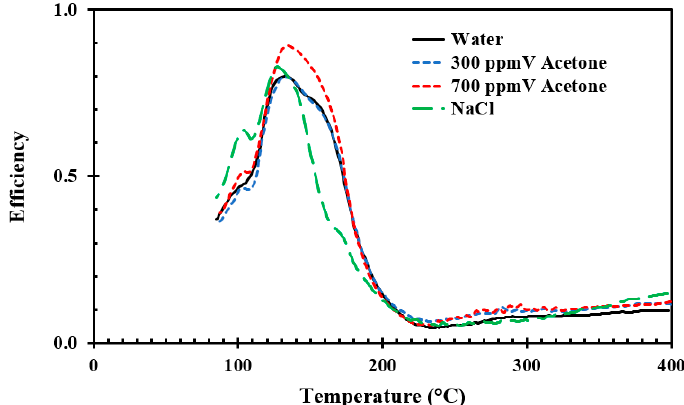
Figure 13. Cooling efficiency for water droplets with and without additives for droplet diameter 2.5 mm, horizontal orientation at impingement height 12.5 cm (speed 1.5 m/s). Energies 2019 , 12 , x FOR PEER REVIEW 10 of 16